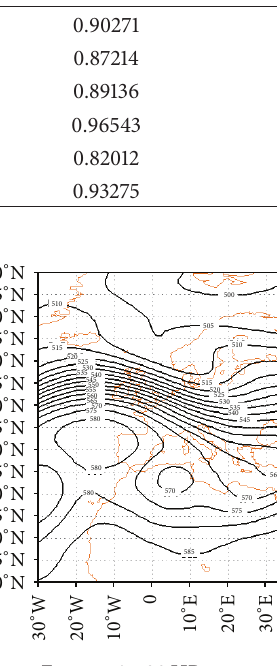
Figure 6: 500 HPa geopotential height level